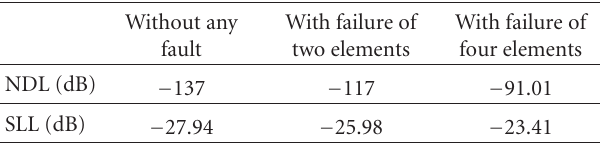
Table 2: Comparison of NDL and SLL for the configurations dis- cussed in Case 1.